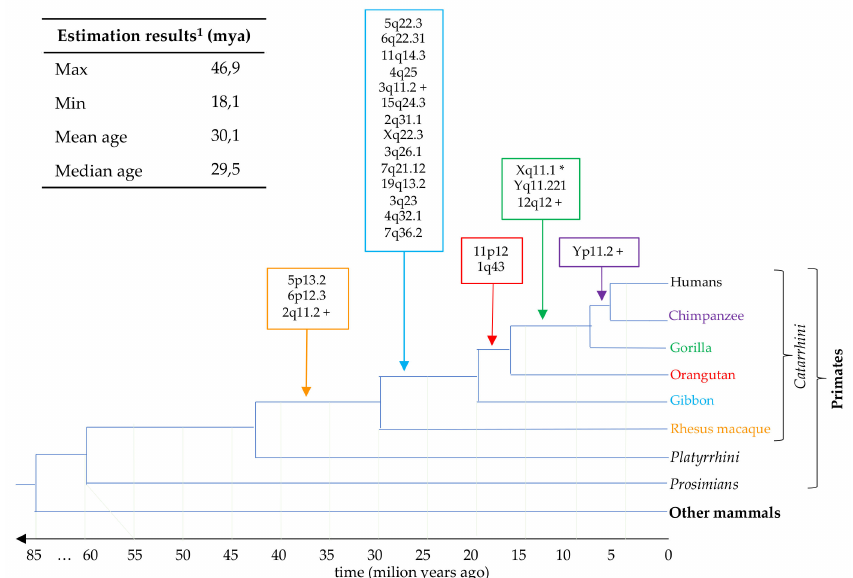
Figure 4. Time of integration of HML7 proviral loci in primate genomes. Temporal overview of the colonization of primate species by HML7 elements, based on the combination of time of integration estimation and comparative genomics analysis of each human locus in non-human primates. Each node indicates a speciation event, and the correspondent time is indicated in the line below. HML7 loci whose insertion occurred in centromeric or pericentromeric regions are marked with a * (Xq11.1) or a + (3q11.2, Yp11.2, 2q11.2 and 12q12), respectively, and their localization in non-human